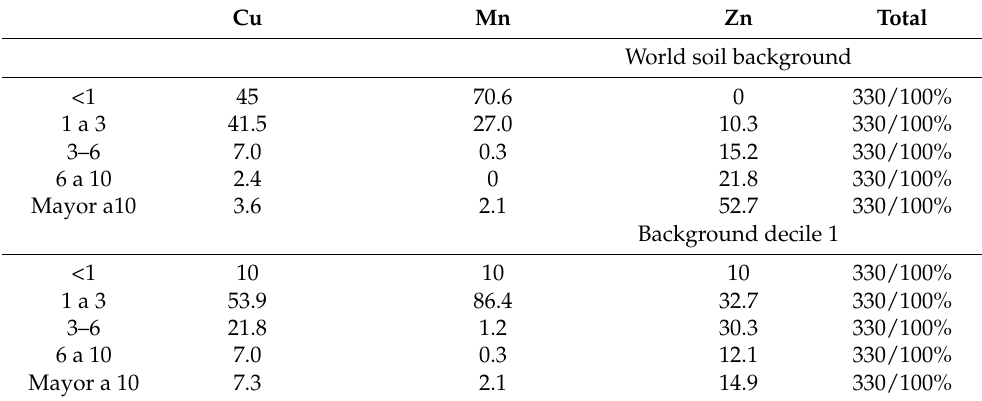
Table 3. Percentage of urban dust samples according to the contamination